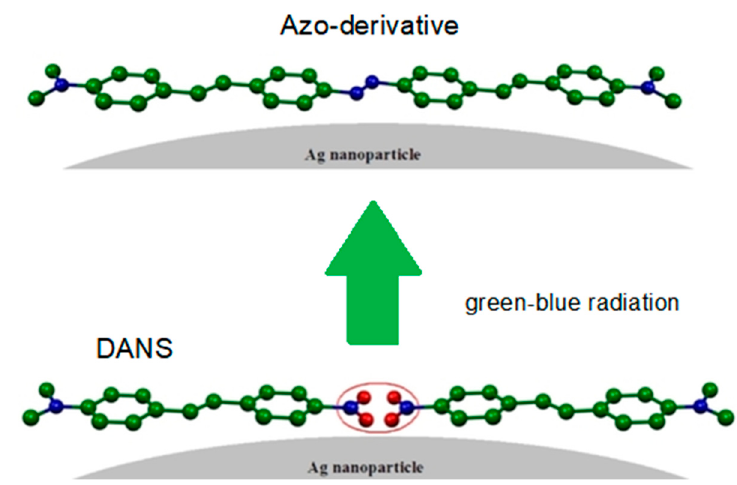
Figure 14. Adsorption and photoreaction of DANS on silver nanoparticles.